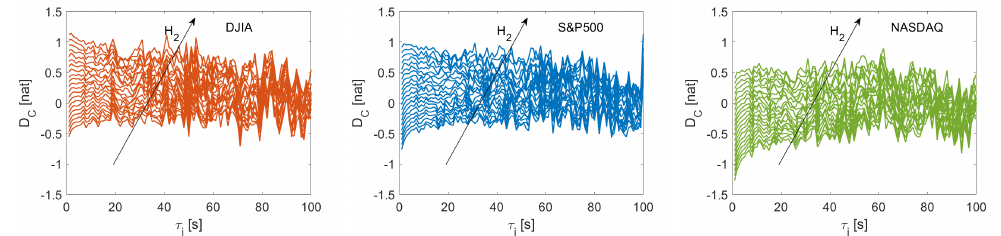
[ P || Q ] , defined by Eq. (5), vs. cluster duration τ . C j [ P || Q ] , as those shown in j , n , n ) re- j and the model probability Q ( τ , n ) referred to t j ranging from 0.50 to 0.70 with step 0.1 as indicated 2